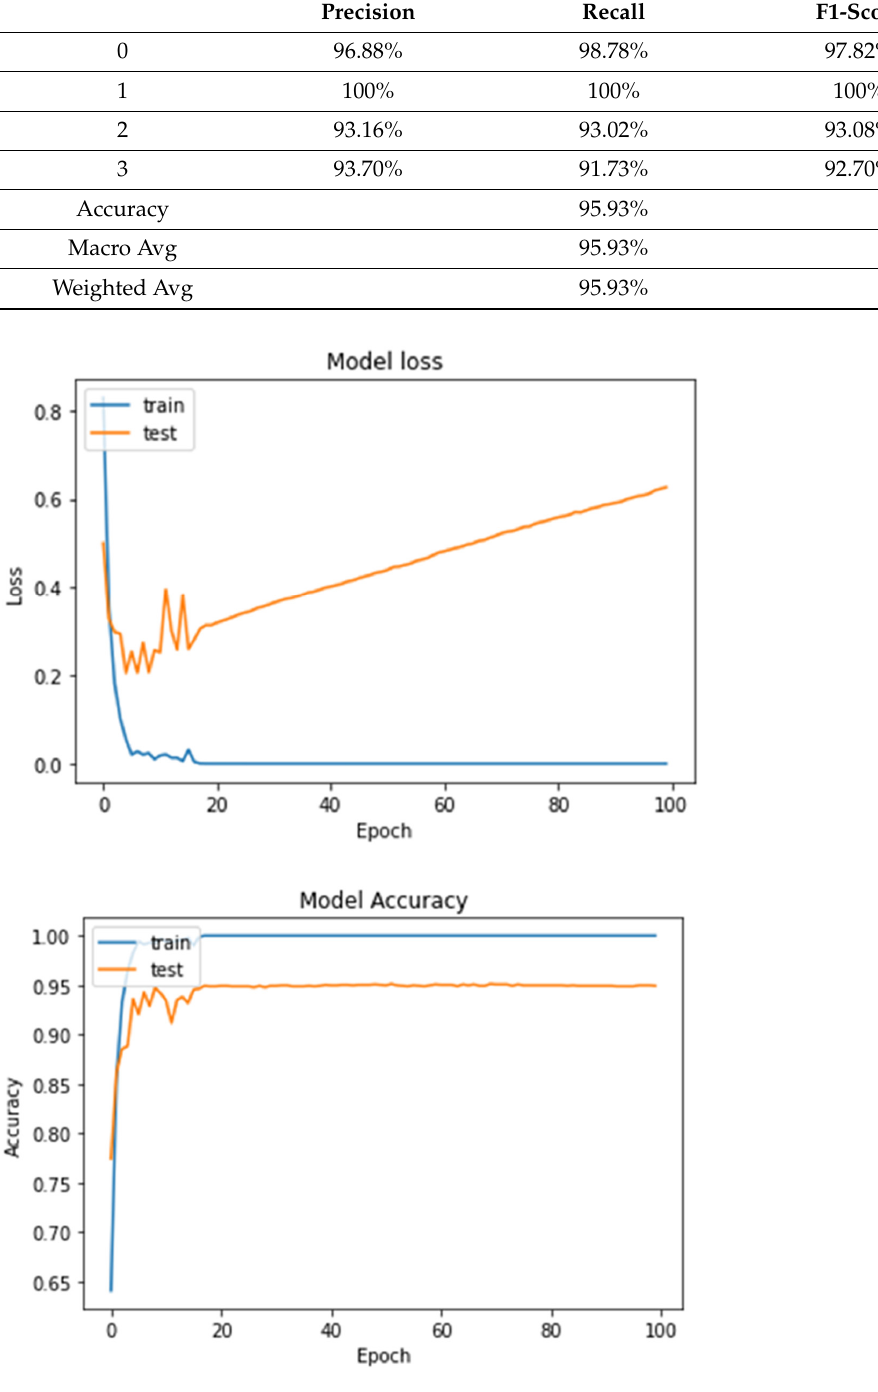
Figure 12. Loss curves ( upper ) and accuracy curves ( lower ) for the training and testing data for the proposed model for multi-classification task.